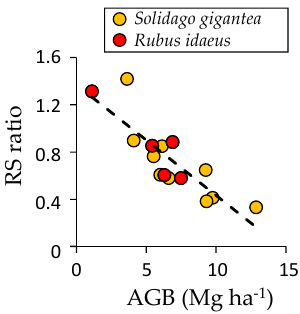
Figure 4. Relation between root/shoot ratio (RS ratio) and aboveground biomass. The broken line represents linear regression for both Rubus ( n = 5) and Solidago ( n = 10) species. Table 2. Belowground biomass (BGB) 1 and its contribution to total biomass.